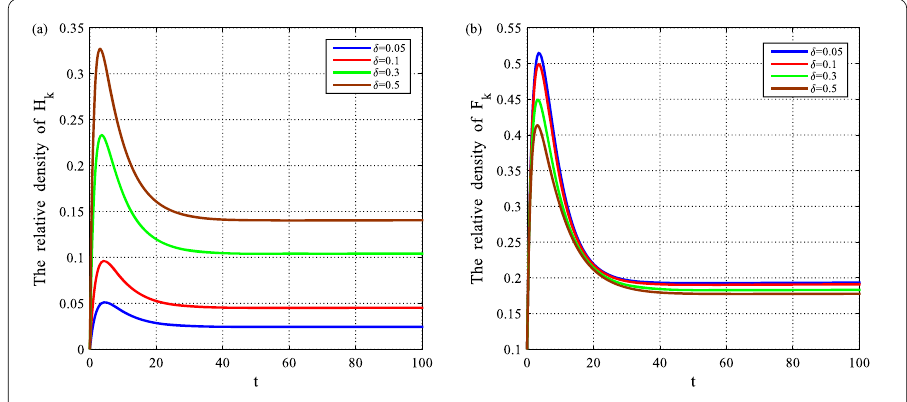
Figure 7 The density of H 200 and F 200 under different δ